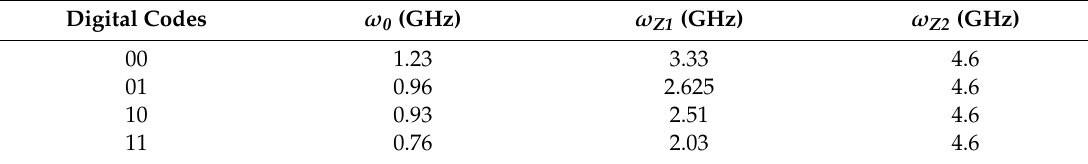
Figure 12. Measured S 21 of the fourth-order Elliptic LPF. Table 1. Fourth-order Elliptic LPF Cut-off and Zero Frequencies.